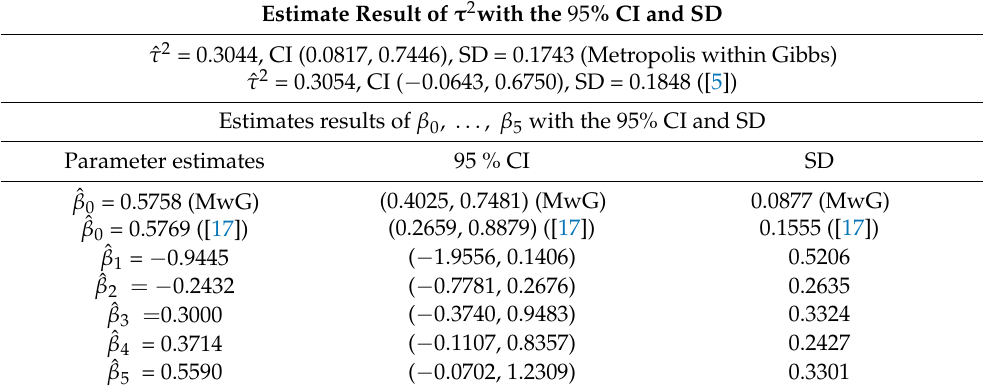
Table 10. Parameter estimates for the HBLM using the Metropolis within Gibbs (case